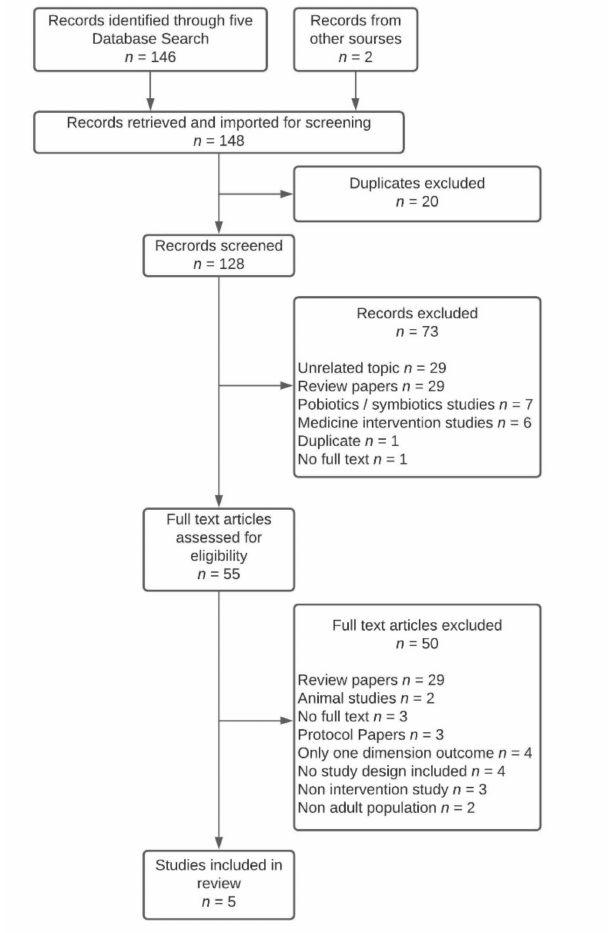
Figure 1. PRISMA flow chart of articles identification and